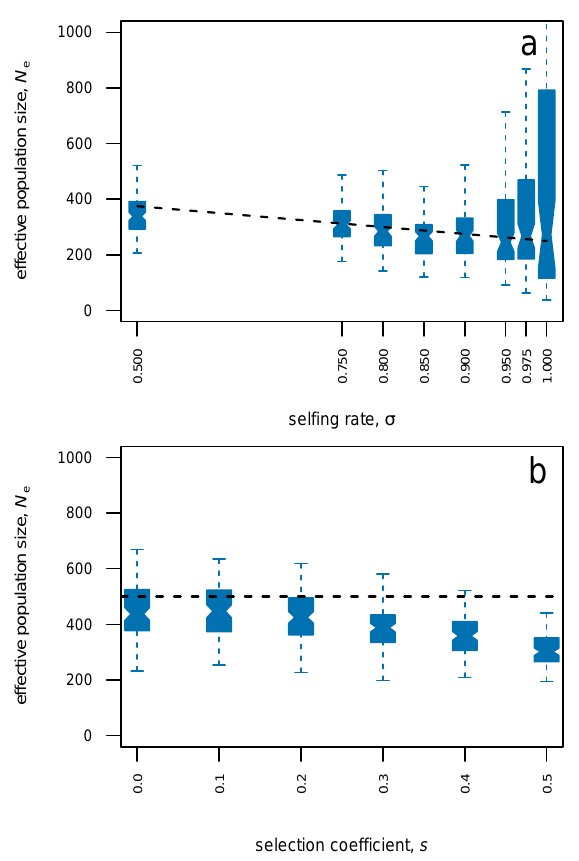
Figure 1 – Effective population size estimates from temporal differentiation. Estimates of N e from F ST were obtained from simulated data of populations of N = 500 diploid individuals, sampled twice with τ = 25 generations between samples and selfing rate σ